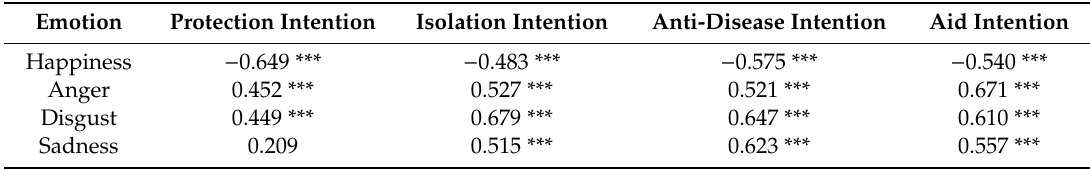
Table 8. Correlation coe ffi cients between emotions and behavioral intentions.